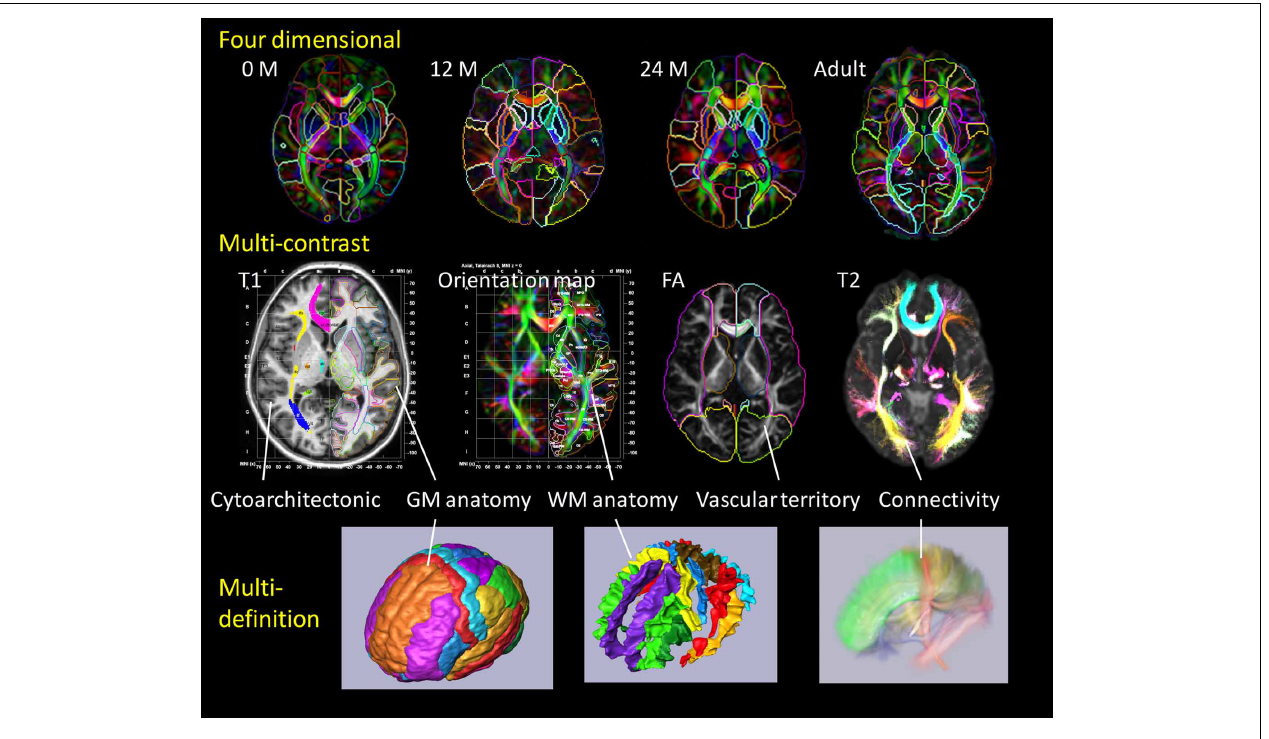
FIGURE 2 | Panels show a current brain atlas, including 3D anatomical information at different developmental stages (multi-dimension), different MR contrasts (multi-contrast), and different structural definitions. The coordinate systems include MNI and Talairach coordinates with the brain depicted as